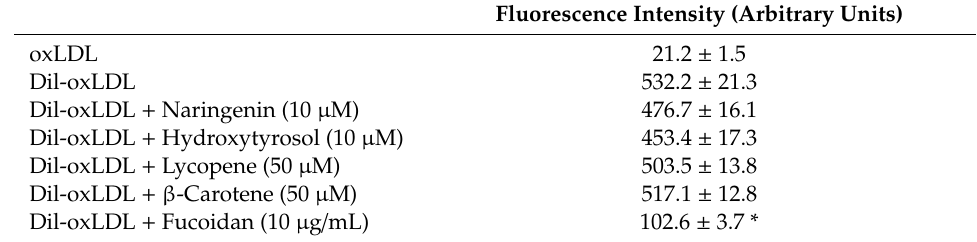
Table 3. E ff ect of sofrito compounds on binding and / or uptake of Dil-labelled oxLDL. Macrophages were incubated with the compounds for 1 h, and then incubated with Dil-oxLDL (50 µ g protein / mL) for 3 h. Then, the cells were washed and lysated and the fluorescence intensity in the lysates were measured. Data are the means ± SEM of three experiments performed in duplicate. * Significant di ff erent from non-treated cells incubated with